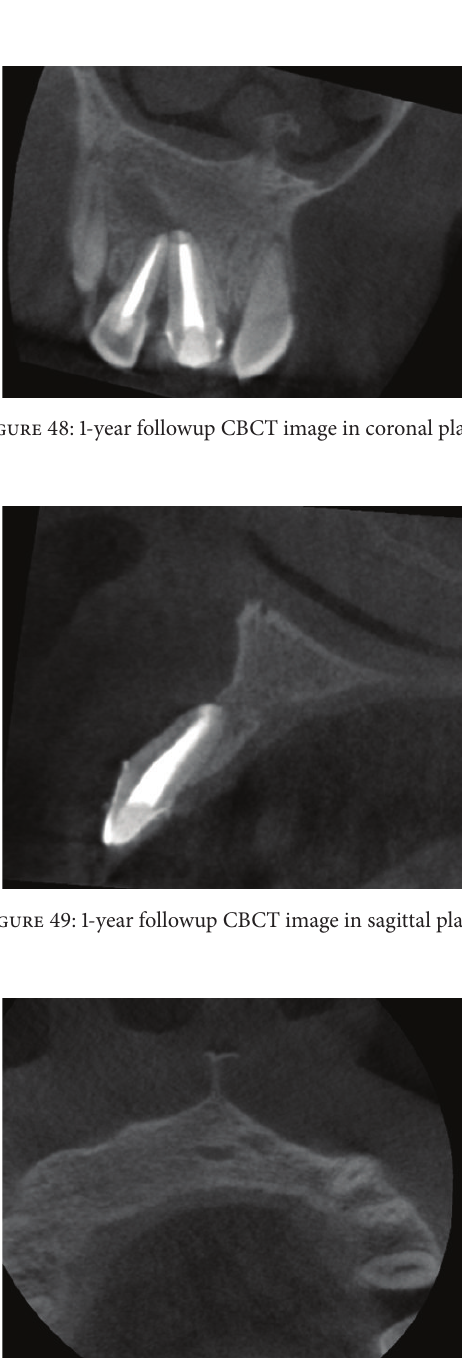
Figure 50: 1-year followup CBCT image in axial plane showing establishment of the buccal and lingual cortical